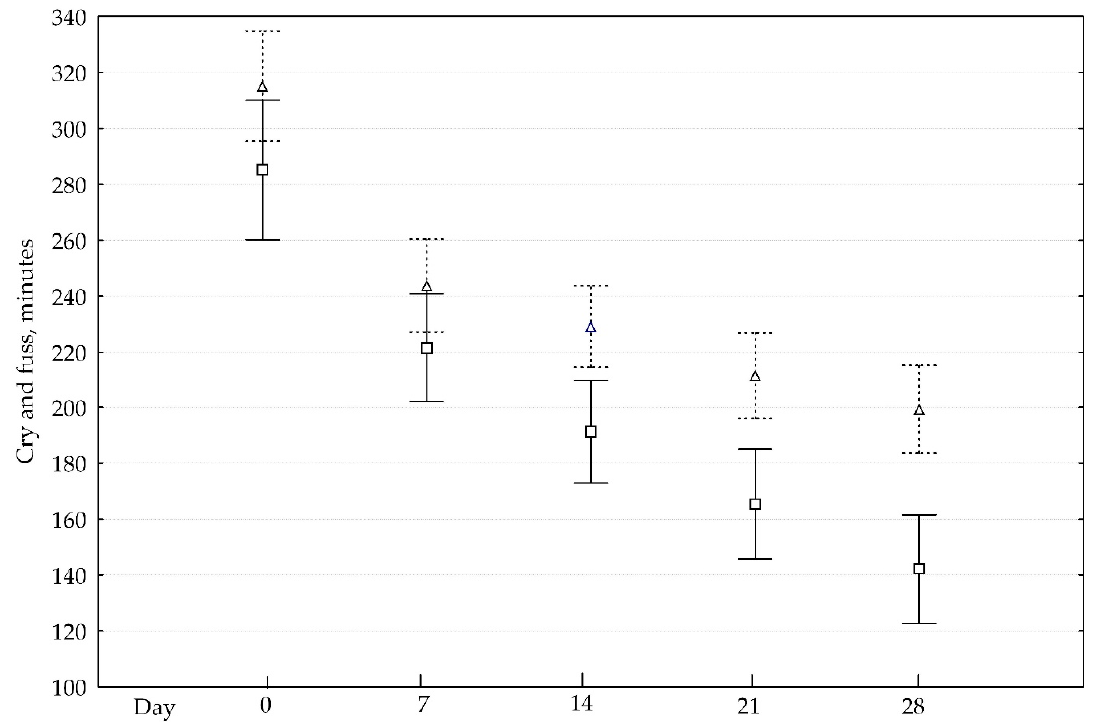
Figure 2. Cry and fuss time over study period. Data present as means (box mark – active; triangle mark - control group) and 2 standard errors (solid whiskers – active; dash whickers - control group).